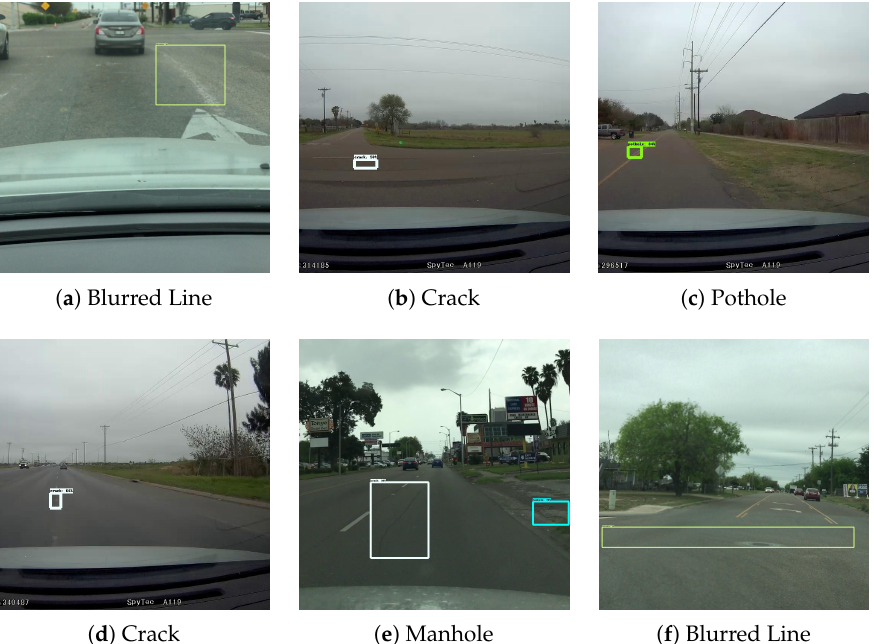
Figure 13. Examples of false positive predicted bounding boxes for the SSD300 MobileNetV2 [19,51] trained